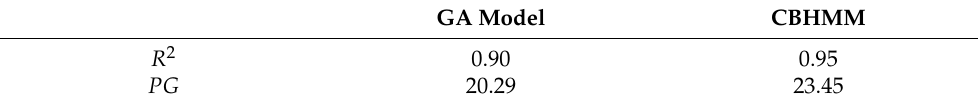
Table 2. Prediction performance using the GA model and CBHMM for the year 2021. GA Model CBHMM R 2 0.90 0.95 PG 20.29